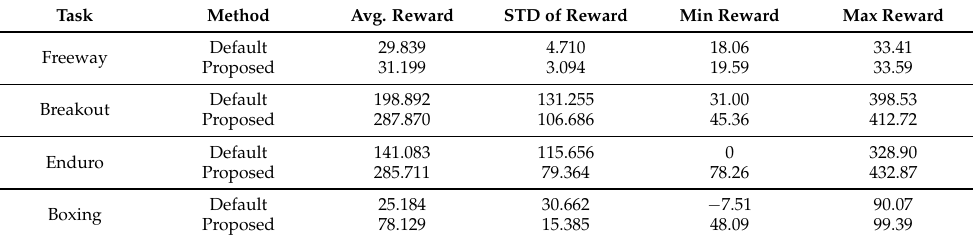
Table 4. Statistical results for the experimentation of the entropy-aware model initialization-based A2C and the conventional